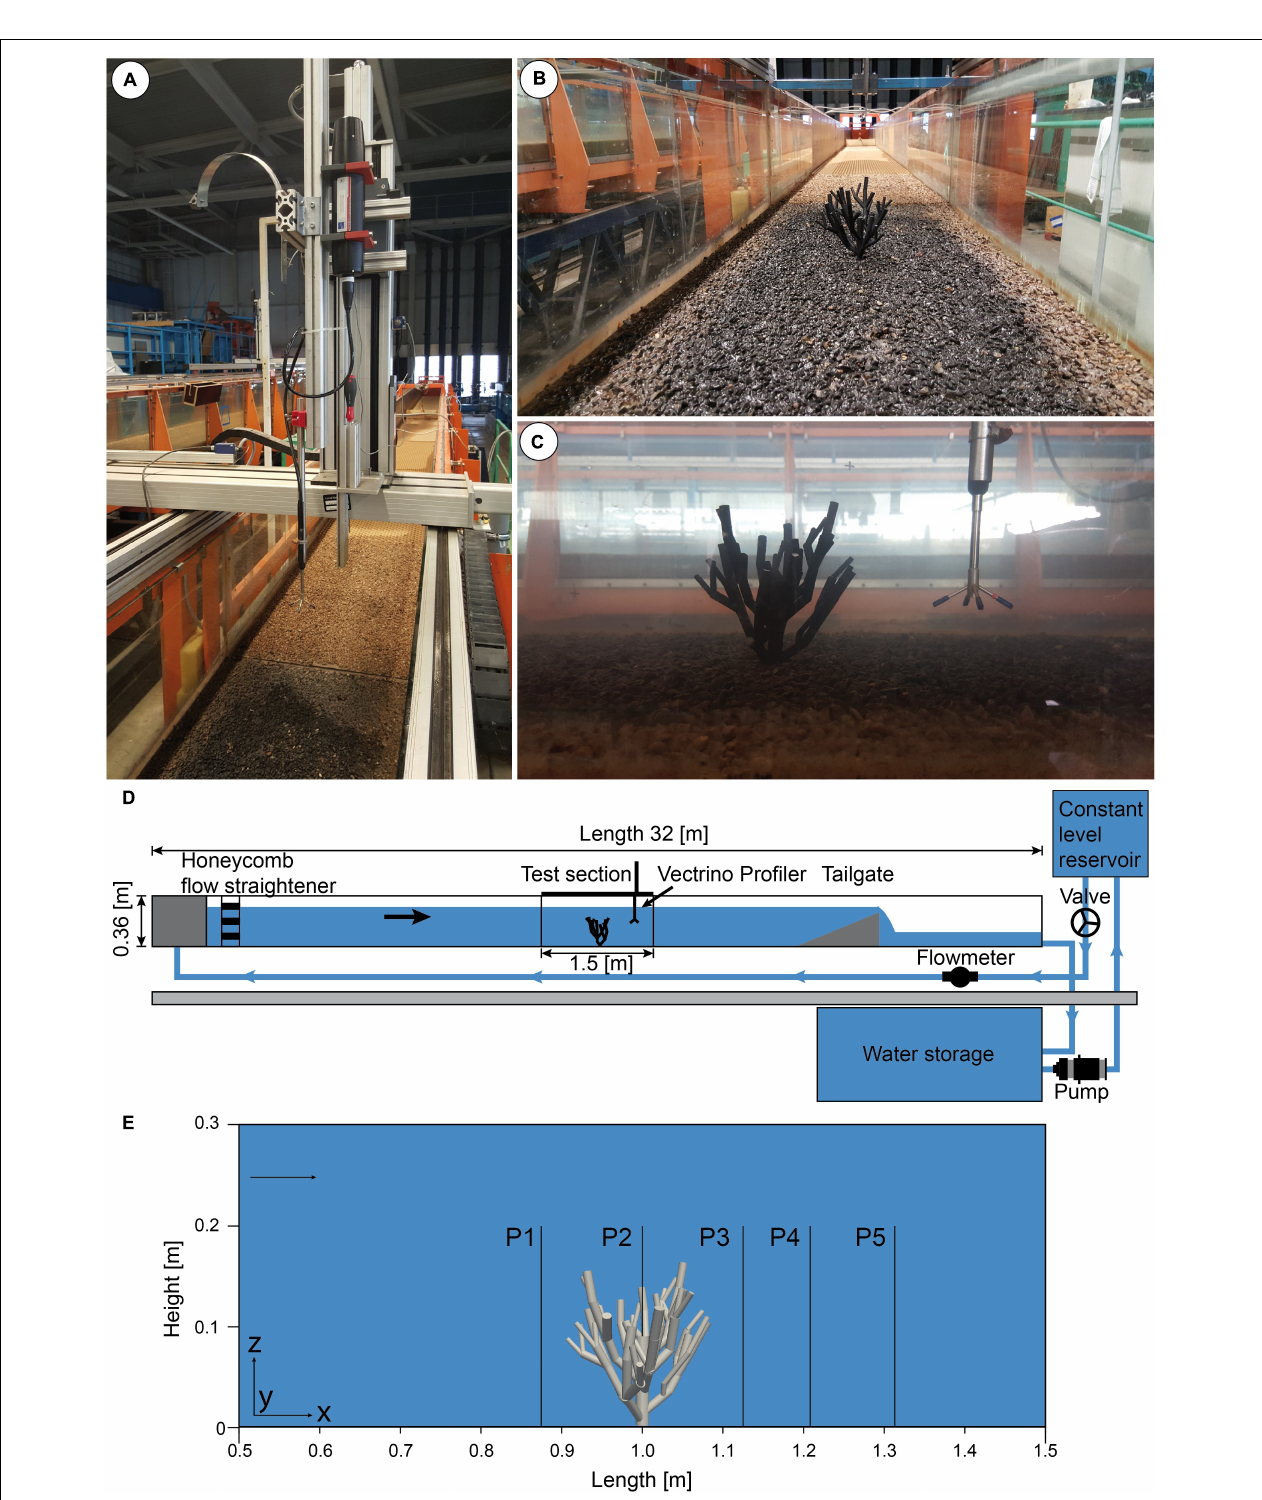
FIGURE 1 | Summary of the laboratory-based flume experiment. (A) Traversing unit mounted above the drained flume with installed Vectrino profiler. (B) View into the downstream direction of the drained flume with the mounted cold-water coral model and roughness elements. (C) Sideview of the experiment showing the cold-water coral model as well as the Vectrino profiler. (D) Schematic of the setup of the flume experiment. (E) Positions of the reference profiles in the test section.